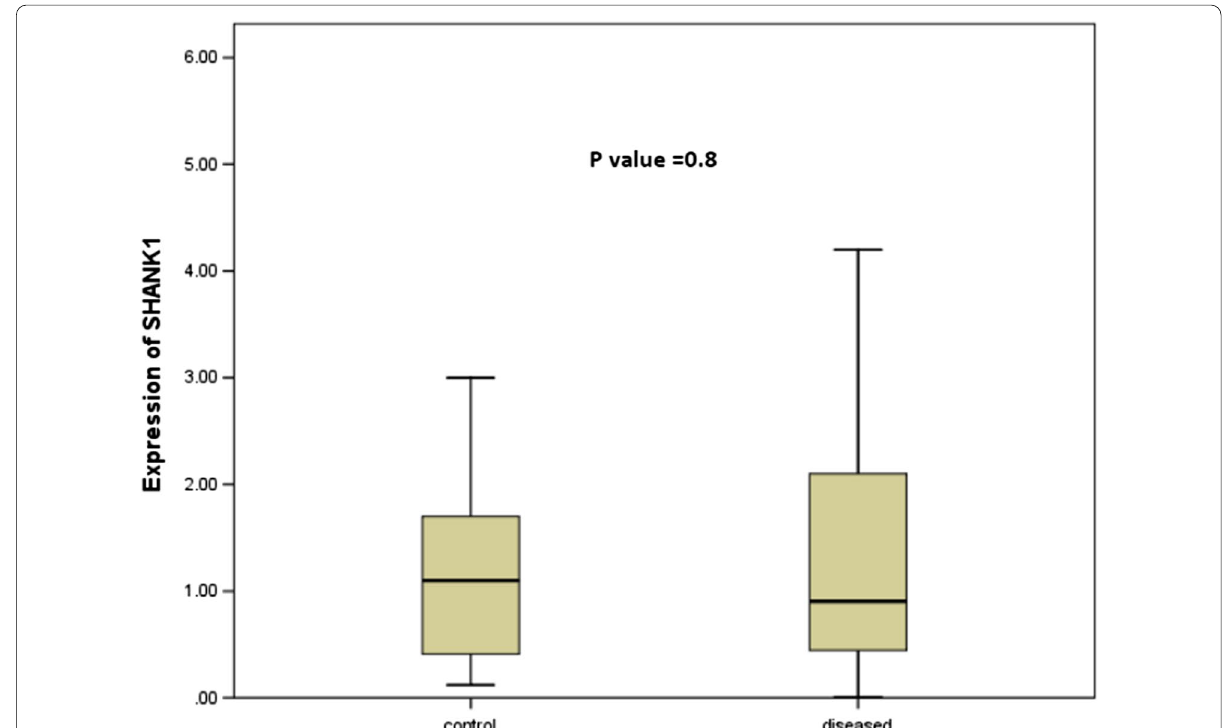
Fig. 4 Shank-1 expression among the studied